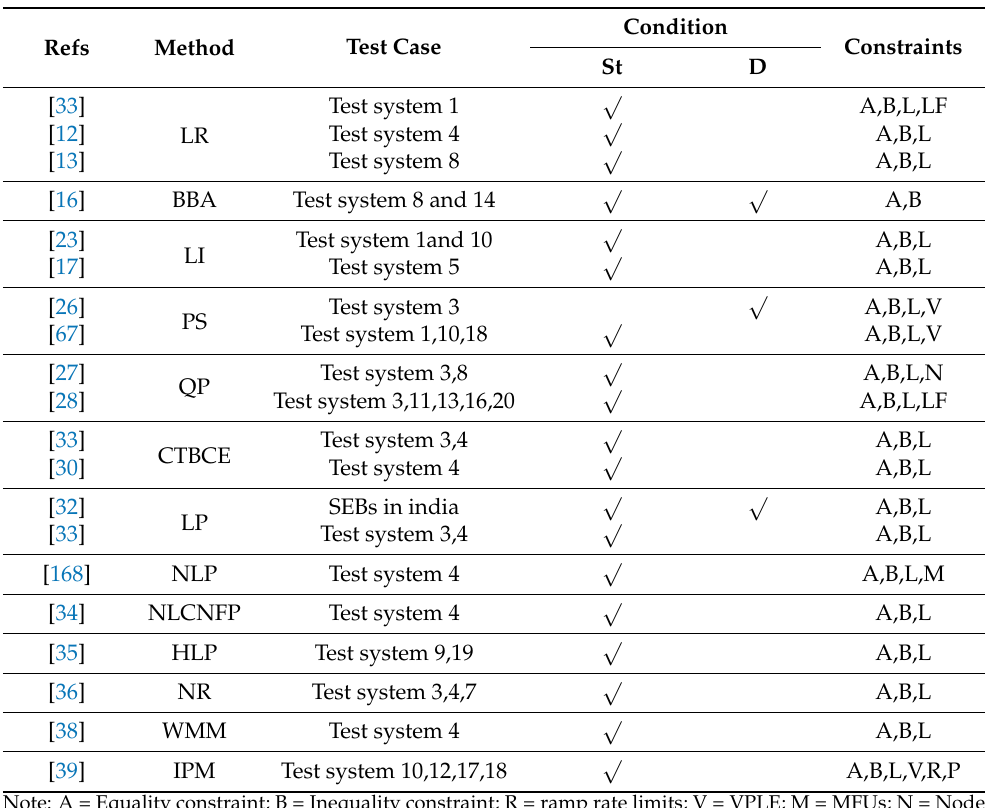
Table 2. Summary of the conventional method related to